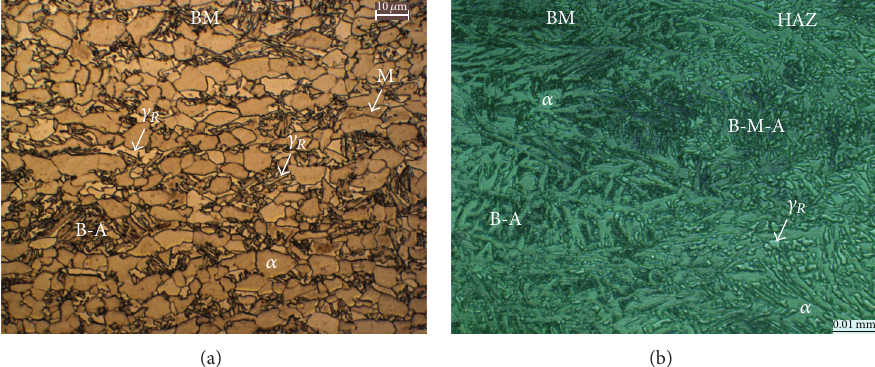
Figure 4: Ferritic-bainitic microstructure containing retained austenite of the base metal (BM) (a) and an intermediate zone between a base metal and HAZ containing an increased fraction of blocky retained austenite grains (b); 𝛼 : ferrite, 𝛾 𝑅 : retained austenite, B-A: bainitic- austenitic regions, M: martensite, B-M-A: bainitic-martensitic-austenitic